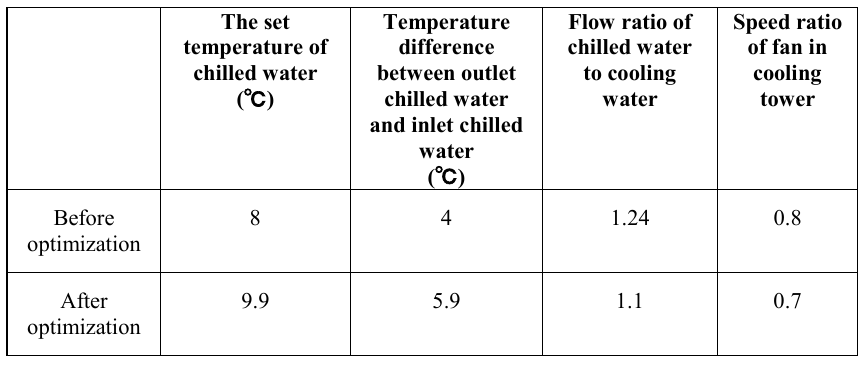
Table 2. Comparison of each variable before and after